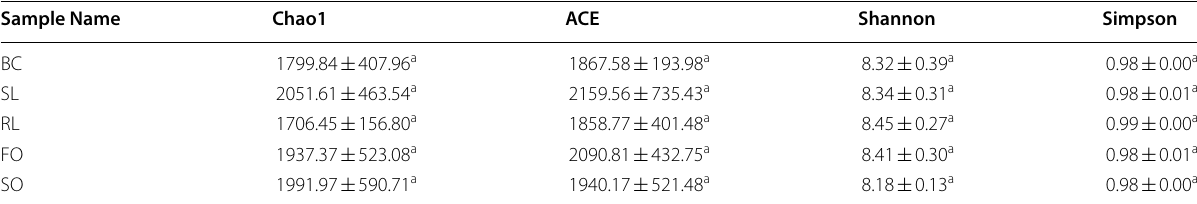
Table 3 Comparisons of gut bacteria on diversity index in response to dietary fats